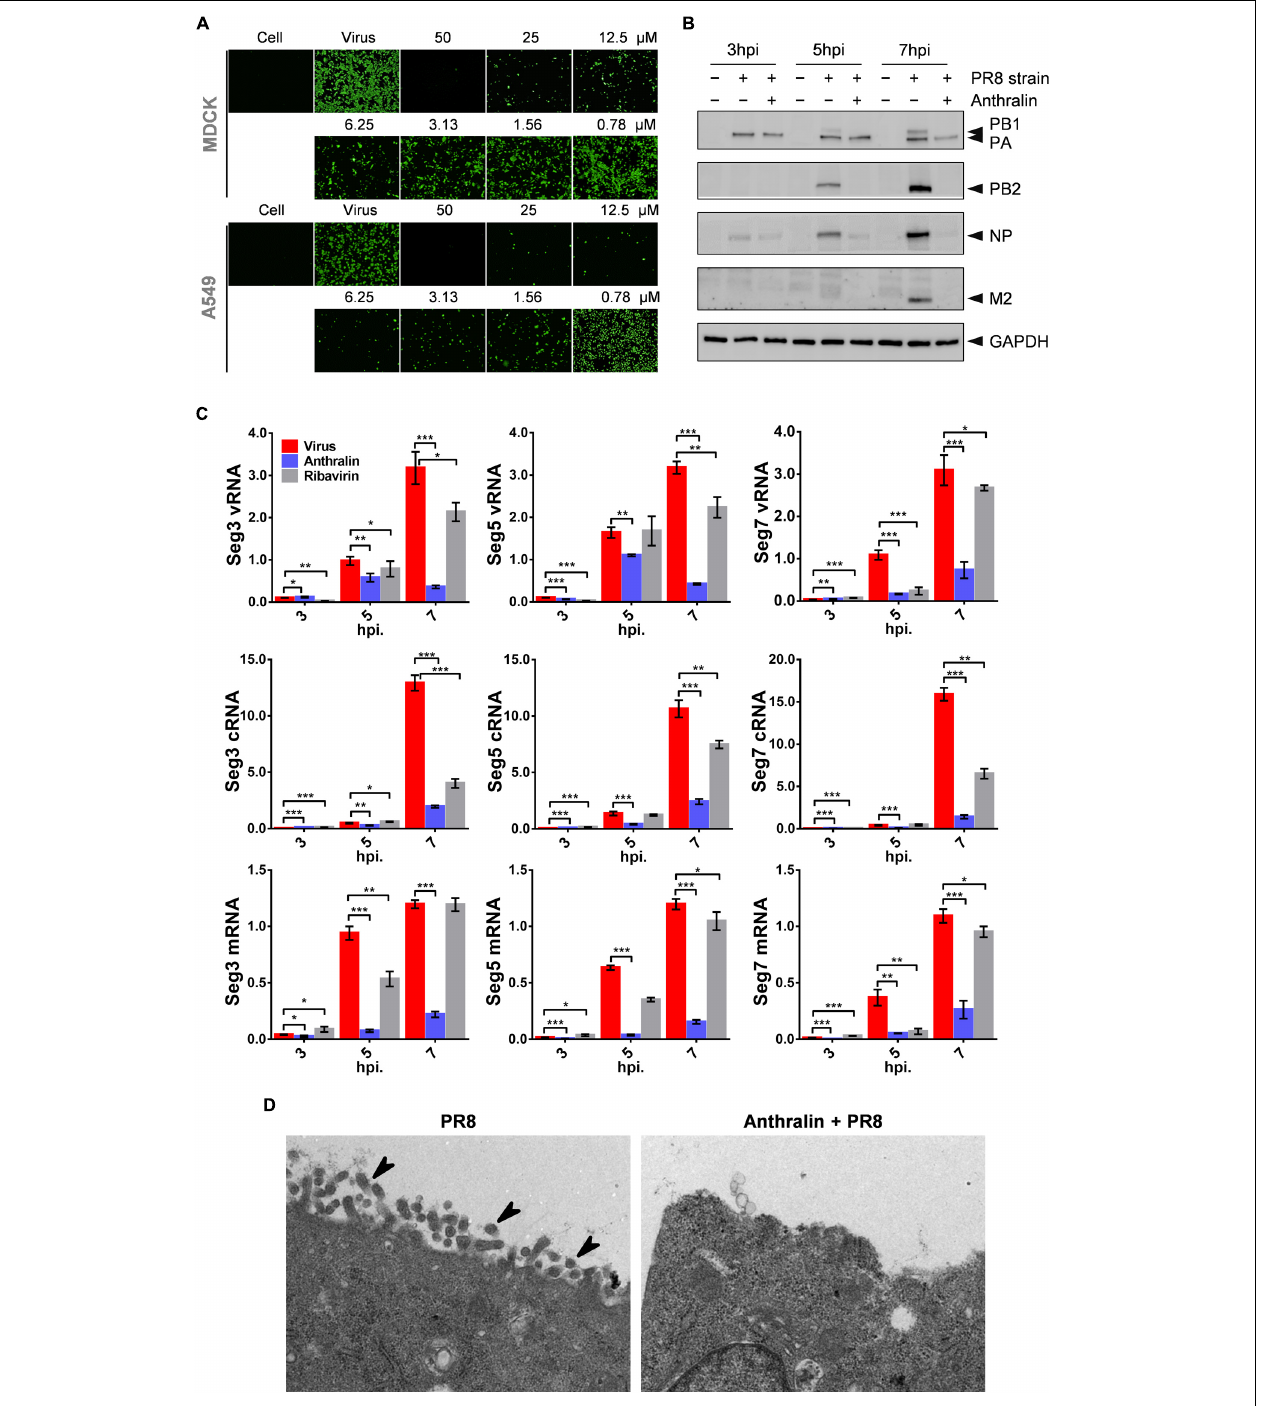
FIGURE 3 | Anthralin inhibits the transcription of the influenza virus and thus interferes with virus replication. (A) MDCK cells were infected with PR8 at an MOI of 0.1 and A549 cells were infected with PR8 at an MOI of 1 and treated with serially diluted anthralin starting from 50 µ M. After 24 h of incubation at 37 ◦ C, the NP expression was measured by indirect immunofluorescence assay using anti-NP. (B) A549 cells were infected with PR8 at an MOI of 5 and viral protein levels were determined by western blotting of the whole-cell lysates collected at the indicated time points. (C) A549 cells were infected with PR8 at an MOI of 5 and incubated for 3, 5, and 7 h. Total RNAs were prepared from cells, and quantitative RT-PCRs were carried out with primer sets specific for vRNA, cRNA and mRNA of the PA, NP or M2, respectively. The results were normalized to the level of 18S rRNA. The averages and standard deviations determined in three independent experiments are shown. Error bars, mean ± SD of three experiments ( n = 3). The level of significance was determined by Student’s t -test (* P < 0.05; ** P < 0.01; *** P < 0.001). (D) Influenza virus infected and anthralin-treated or untreated A549 cells were immobilized 8 h after infection. Viral particles inside and outside of the cells were observed using transmission electron microscopy (the arrows in the diagram point to